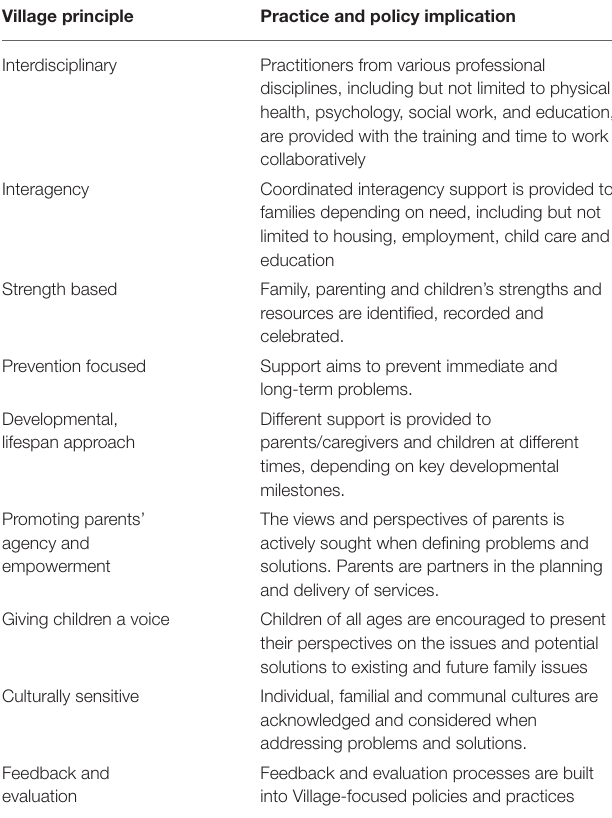
TABLE 1 | Potential principles of the village approach. Village